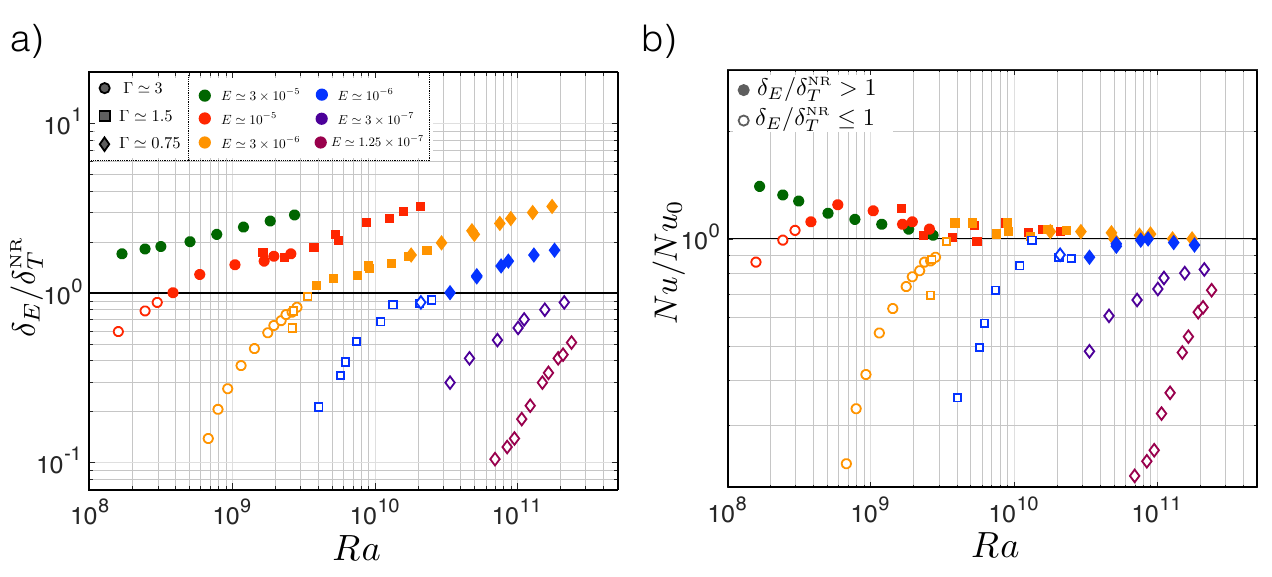
Figure 6. ( a ) Estimated Ekman layer thickness, δ E = 3 E 1/2 H [97], normalized by the estimated = H / ( 2 Nu ) [64], vs. Ra . Colored symbols are hollow RBC thermal boundary layer thickness, δ NR T > 1. ( b ) Nu normalized by the non-rotating style scaling, when δ E / δ NR 1 and solid when δ E / δ NR T ≤ T Nu 0 = 0.108 Ra 0.309 , vs. Ra . Colored symbols are hollow or solid based on the criteria used in ( a ). We see that hollow symbols generally occur where Nu / Nu 0 (cid:46)